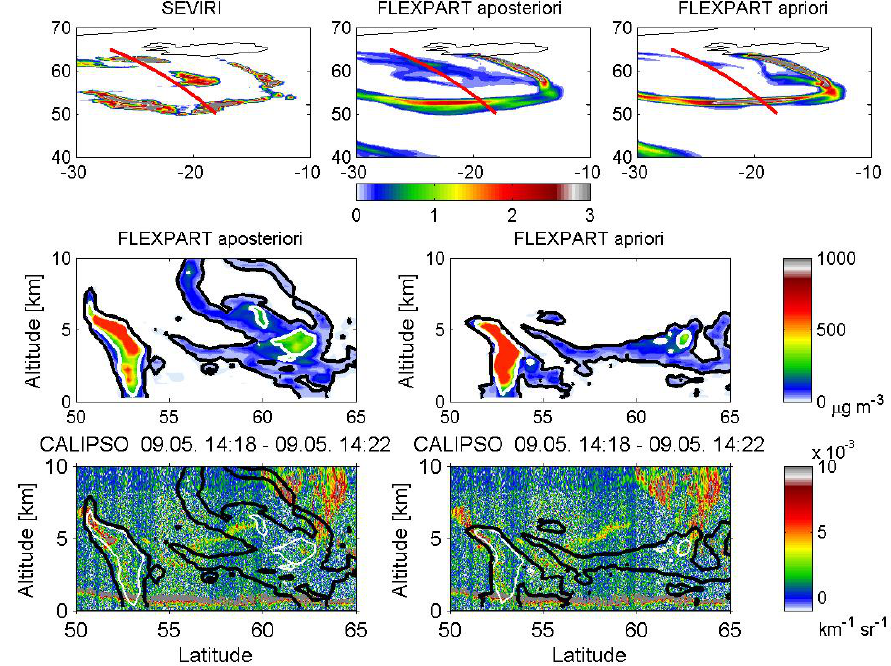
Fig. A2. Same as Fig. A1, but for 9 May at